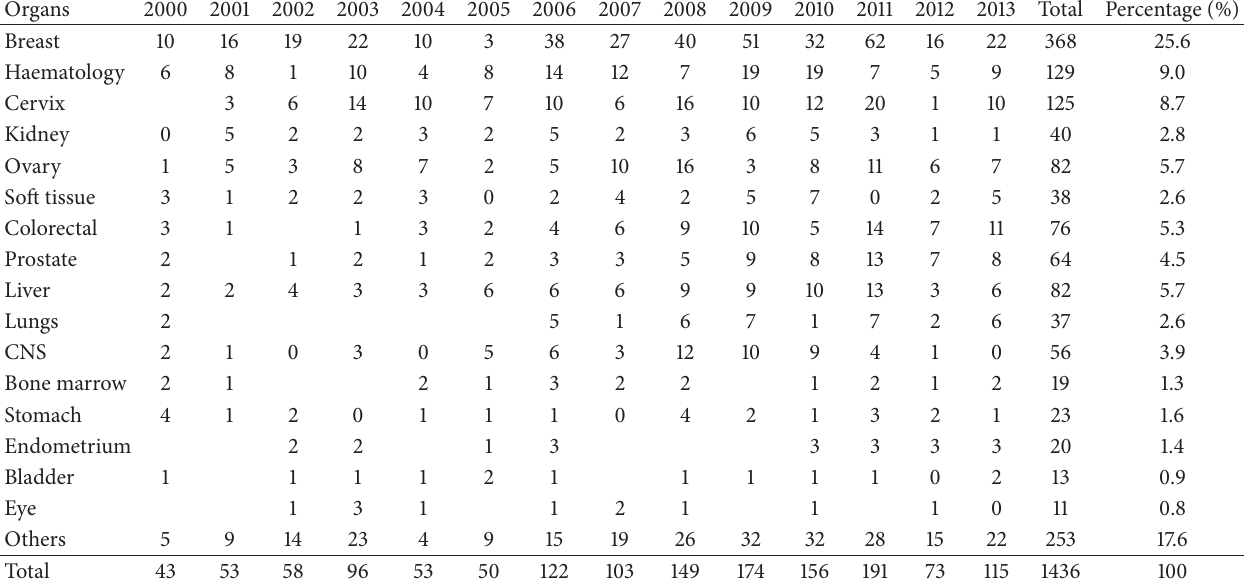
Table 3: Showing organ specific and yearly distribution of cancer mortality.